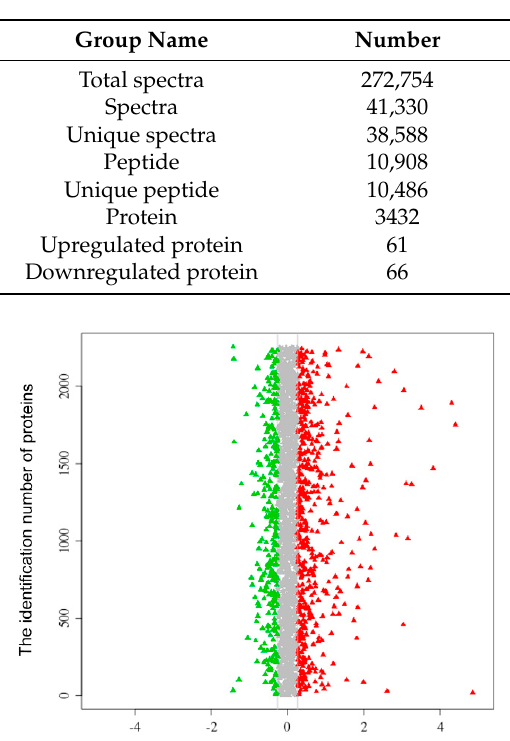
Table 1. Overview of the proteomics sequencing results.